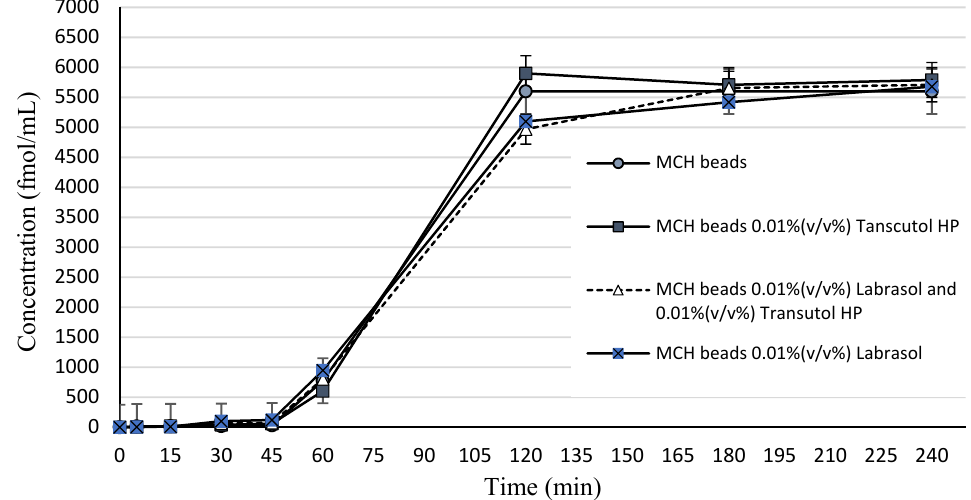
Figure 5. In vitro dissolution profile of MCH from sodium-alginate beads in phosphate buffer solution (pH = 6.80). Significant peptide release started after 60 min and reached a plateau after 120 min. Each data point represents the mean ± SD, n = 3.